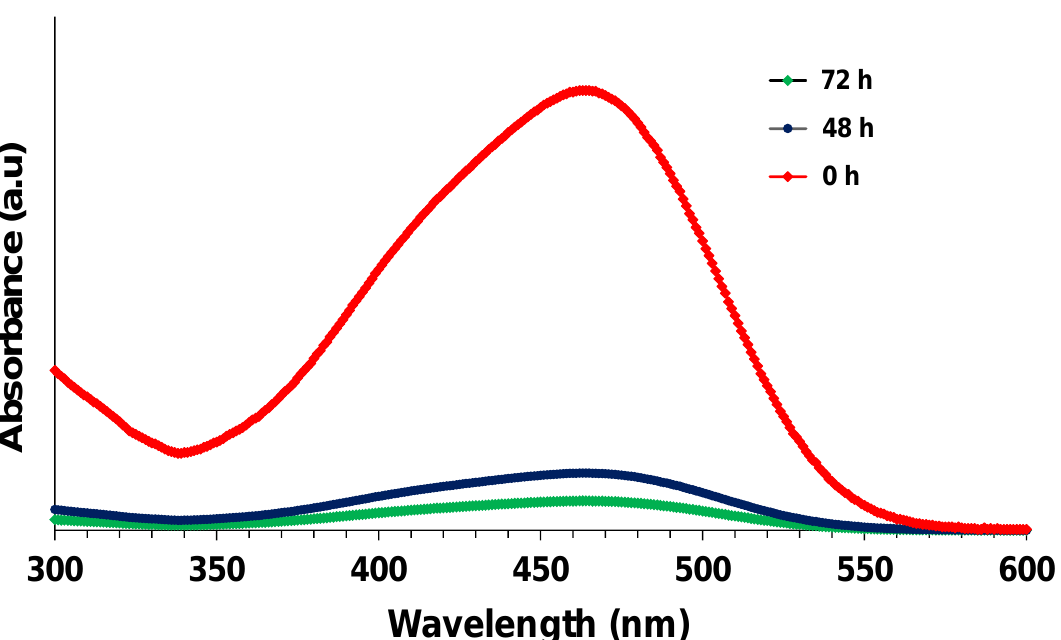
3 − -N, and MLSS. Figure 8. Profiles of colour, COD, NO